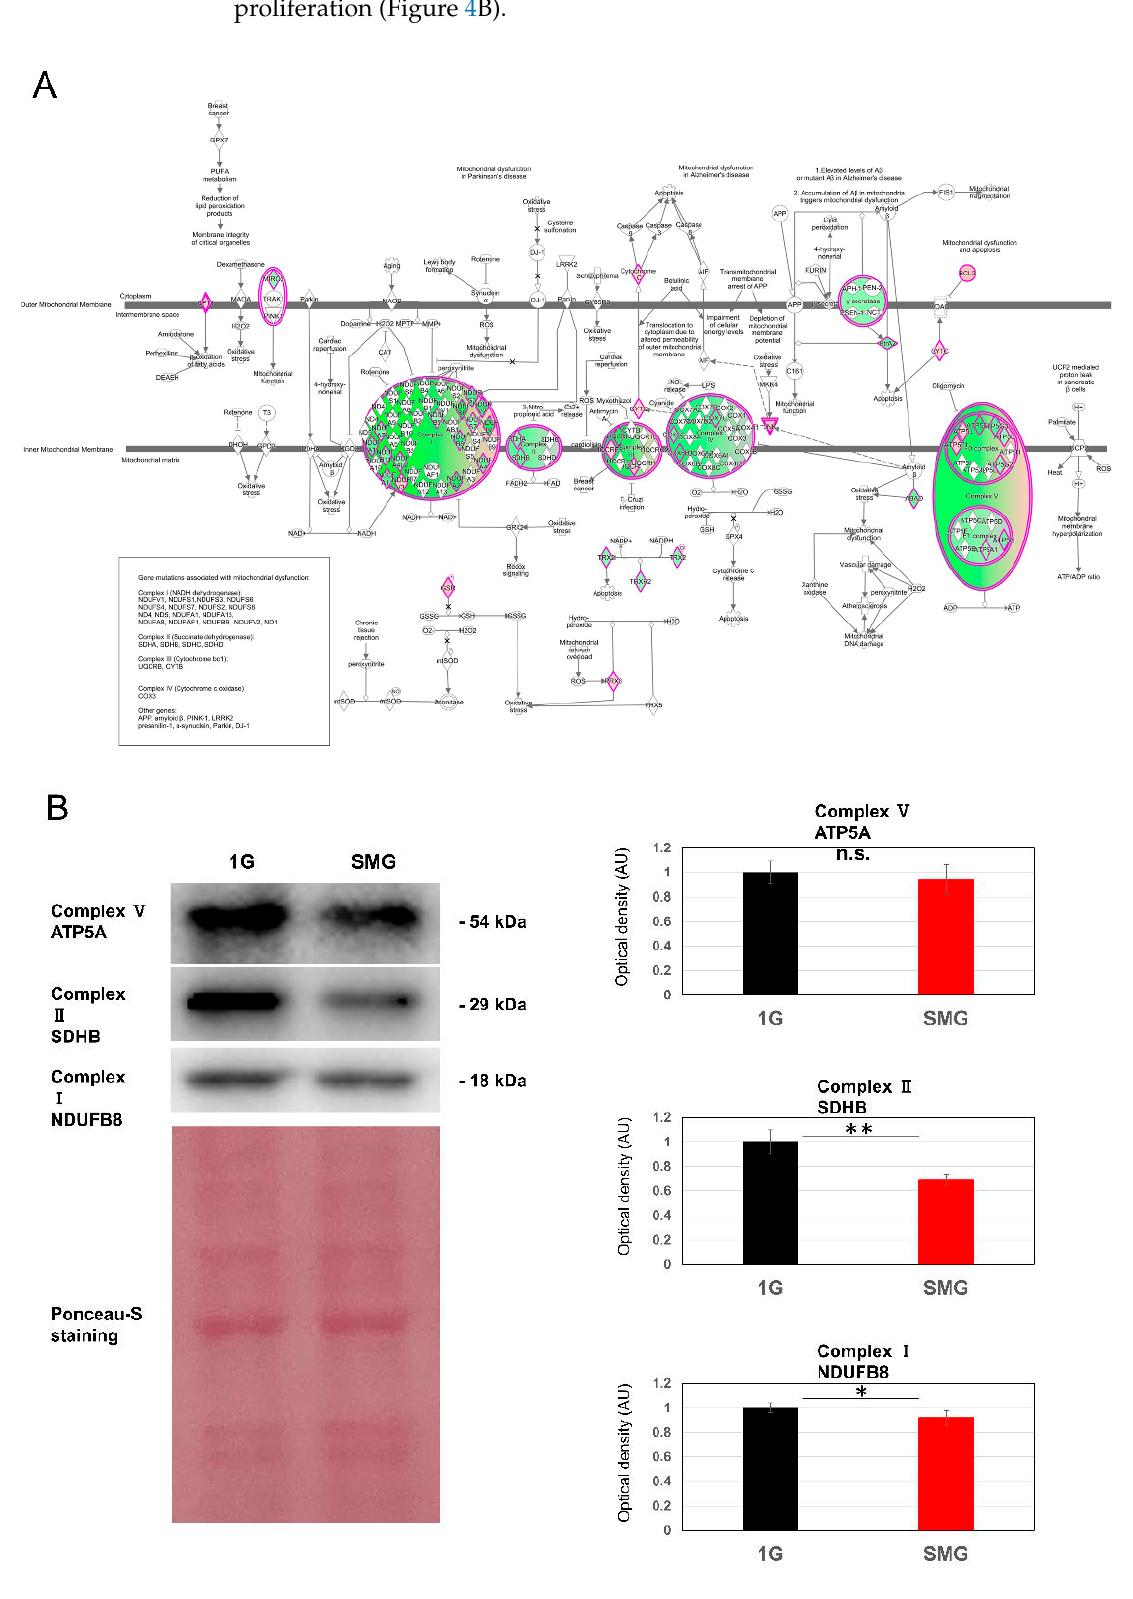
Figure 3. ( A ) Pathways related to mitochondrial dysfunction. Illustration of altered genes involved in IPA canonical pathway “mitochondrial dysfunction”. Overlap p -values, a measure of the overlap between observed gene expression changes and known targets regulated by transcriptional regula- tors, were calculated using Fisher’s exact test. Activation z-score (z-score), an indicator of the regu- latory direction of a pathway, was calculated based on a database of molecular networks represent- ing experimentally observed gene expression or transcriptional events, where a positive z-score means “activation” and a negative z-score means “repression”. In the mitochondrial dysfunction- pathway map obtained by IPA [13], upregulated components of gene expression involved in mito-